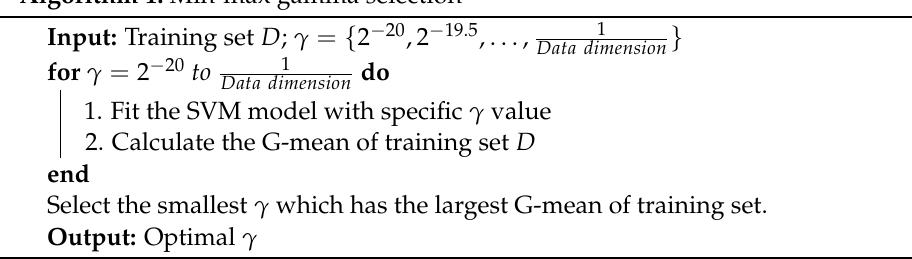
Algorithm 1: Min-max gamma